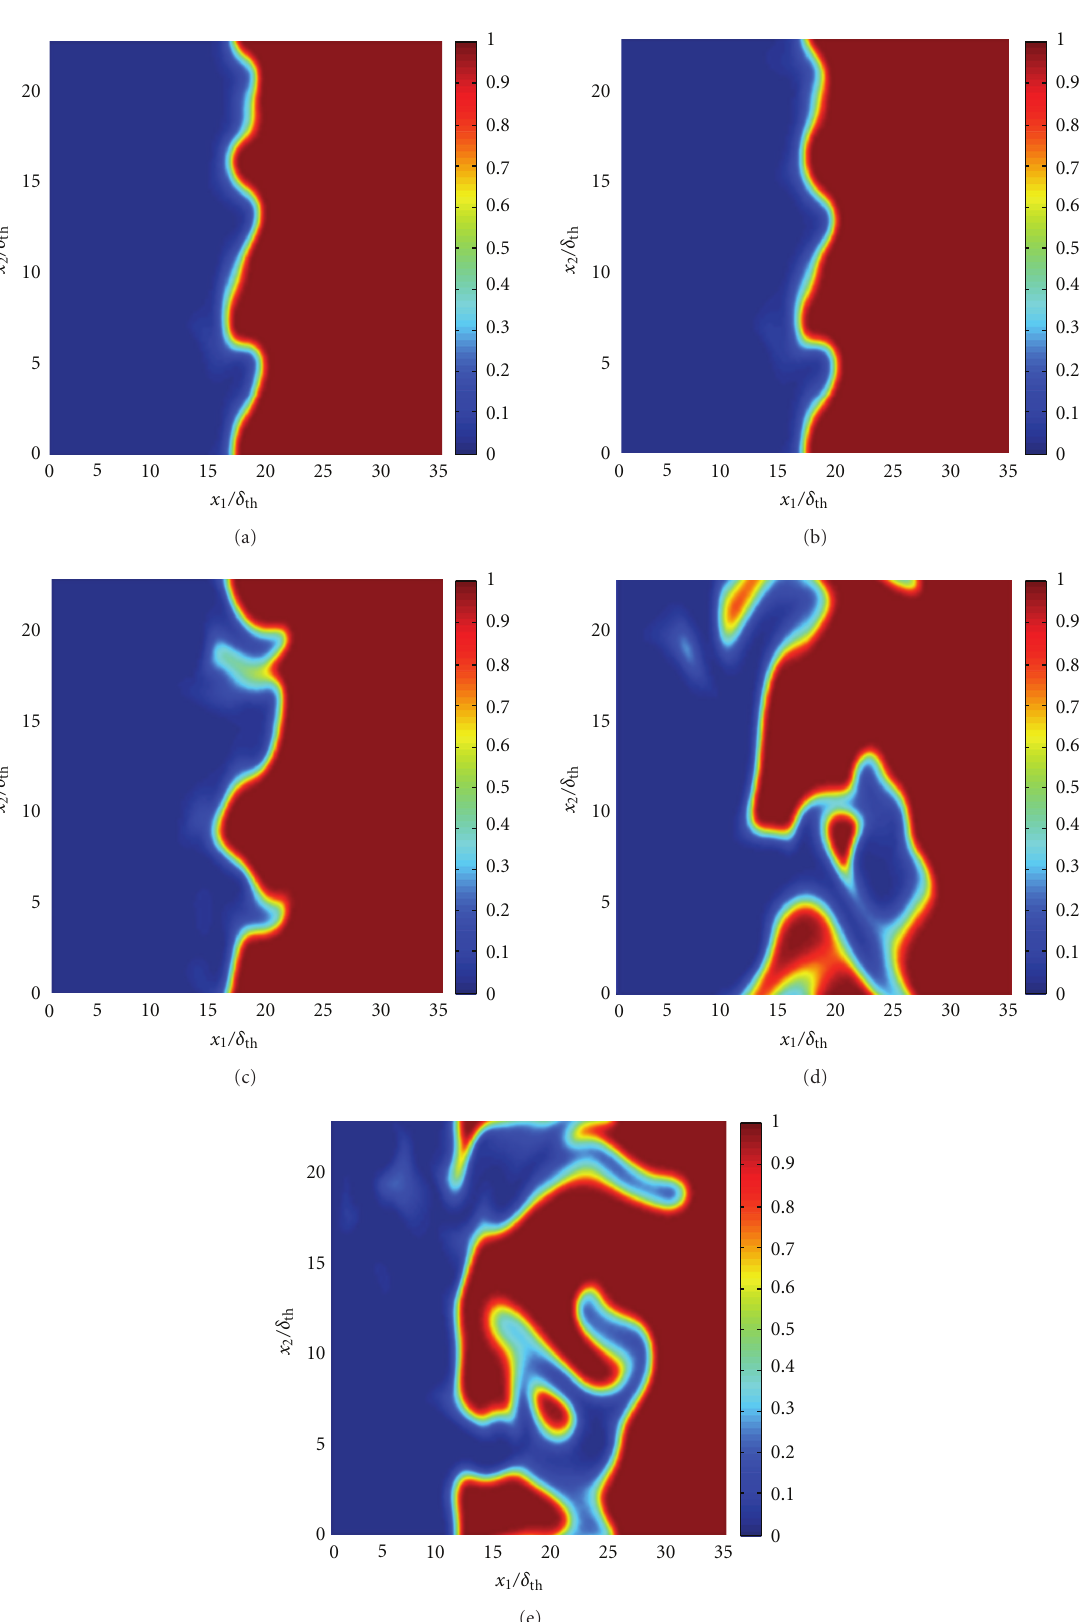
Figure 1: Contours of reaction progress variable c in the x 1 - x 2 midplane of the domain after t = 1 . 0 δ th /S L for: (a) case A; (b) case B; (c) case C; (d) case D; (e) case